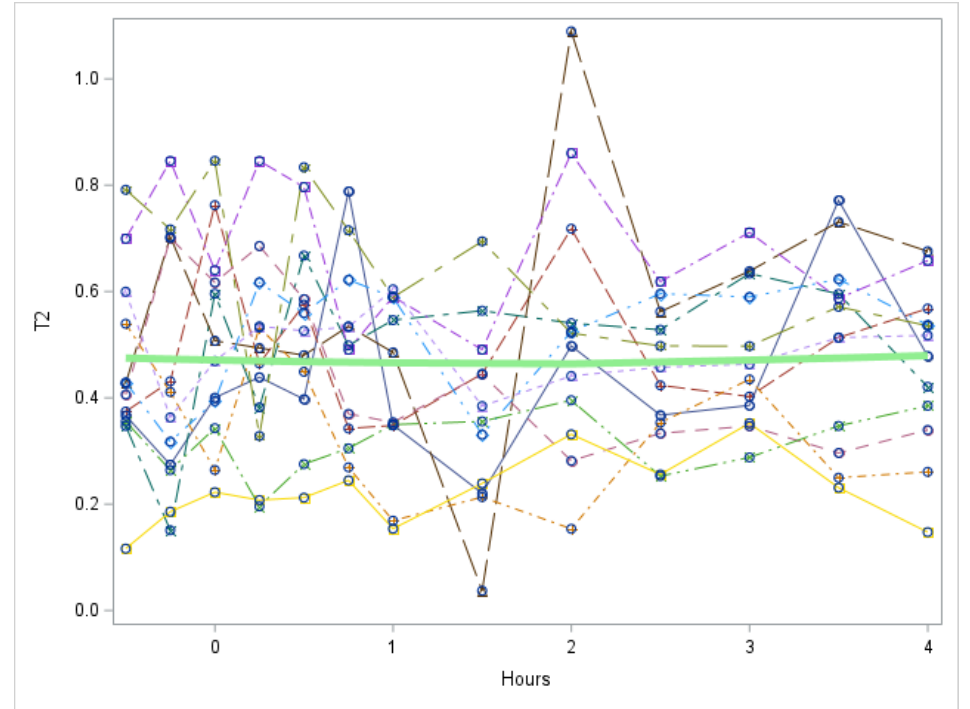
Figure A3. Study 1: 3,5-T2 trend in first 5 h after LT3 dose (Each individual line represents a participant. The green line represents the mean values for all participants). T2 = 3,5-T2 concentration in nmol/L. There is no significant change in 3,5-T2 during the first five hours, p value = 0.7421.